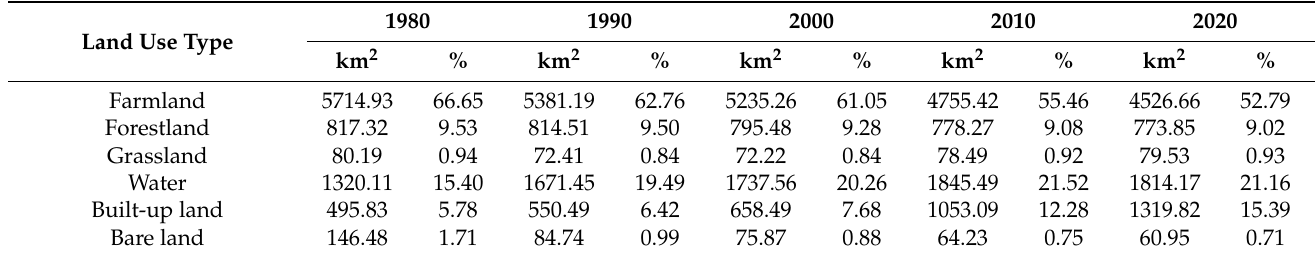
Table 3. Area of six land use types in Wuhan city, China.